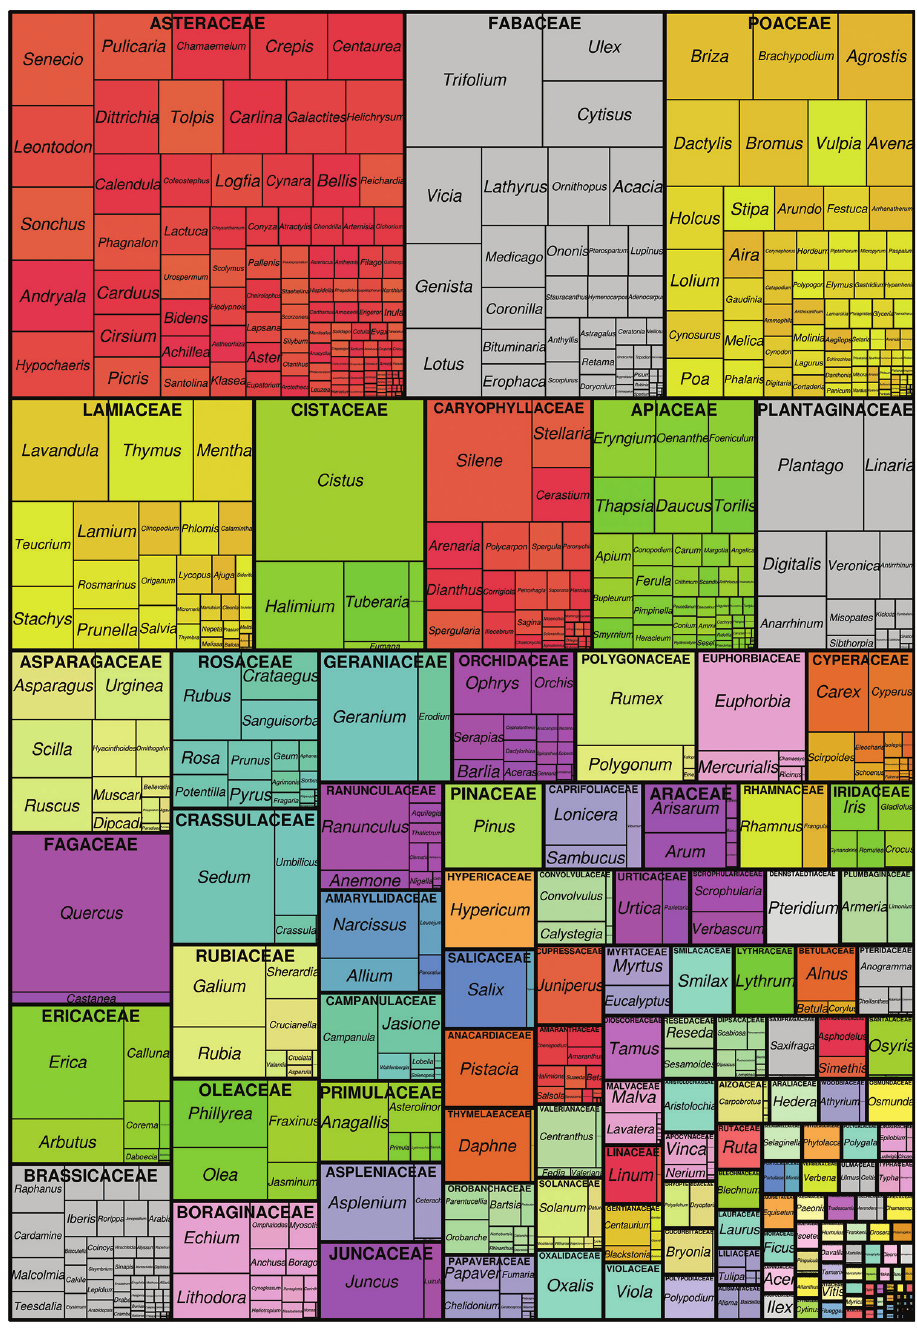
Figure 3. Tree map of the Flora-On dataset based on a two-level taxonomic classification. Families are delineated with thick lines and genera with thin lines. The size of the rectangles is proportional to the number of records held. The plot was built with the R package ‘treemap’ (Tennekes